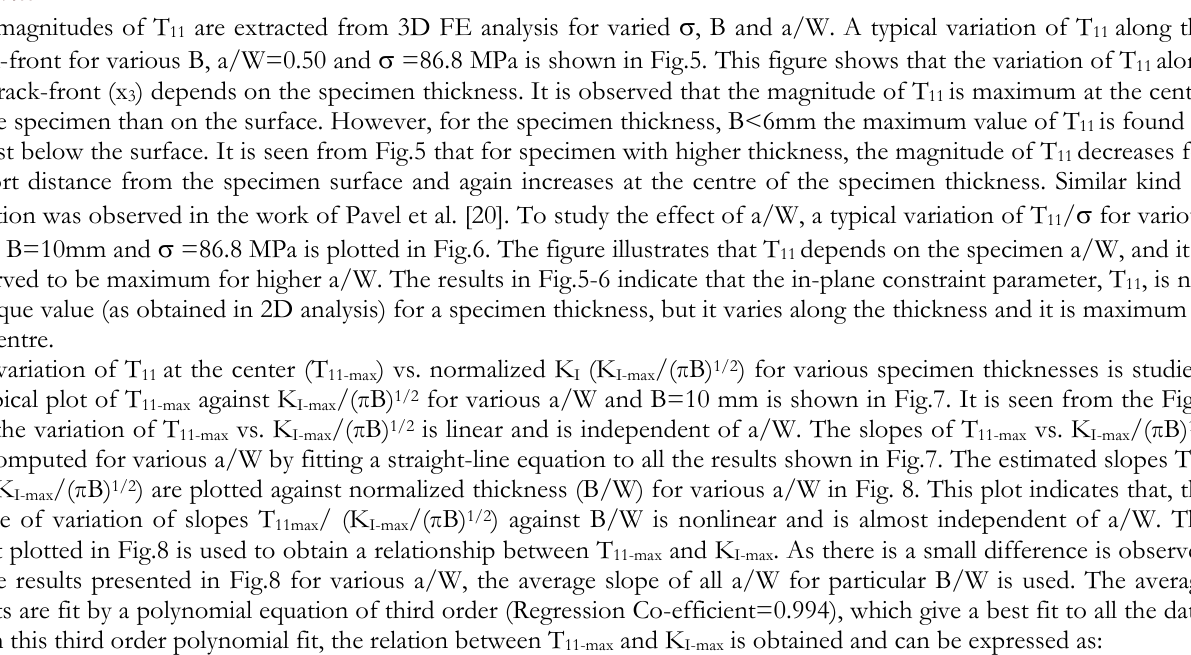
Figure 5: A typical variation of T 11 /  along the crack-front for various B and a/W =0.50. T 11